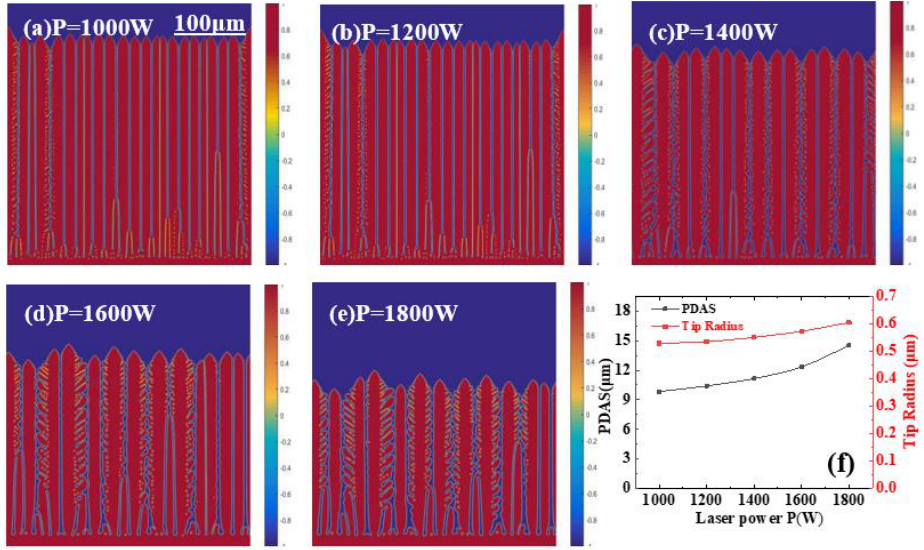
Figure 5. Analysis of dendrite morphology under different laser powers. ( a ) P = 1000 W, ( b ) P = 1200 W, ( c ) P = 1400 W, ( d ) P = 1600 W, ( e ) P = 1800 W, ( f ) Effect of laser power on dendrite arm spacing and tip radius.